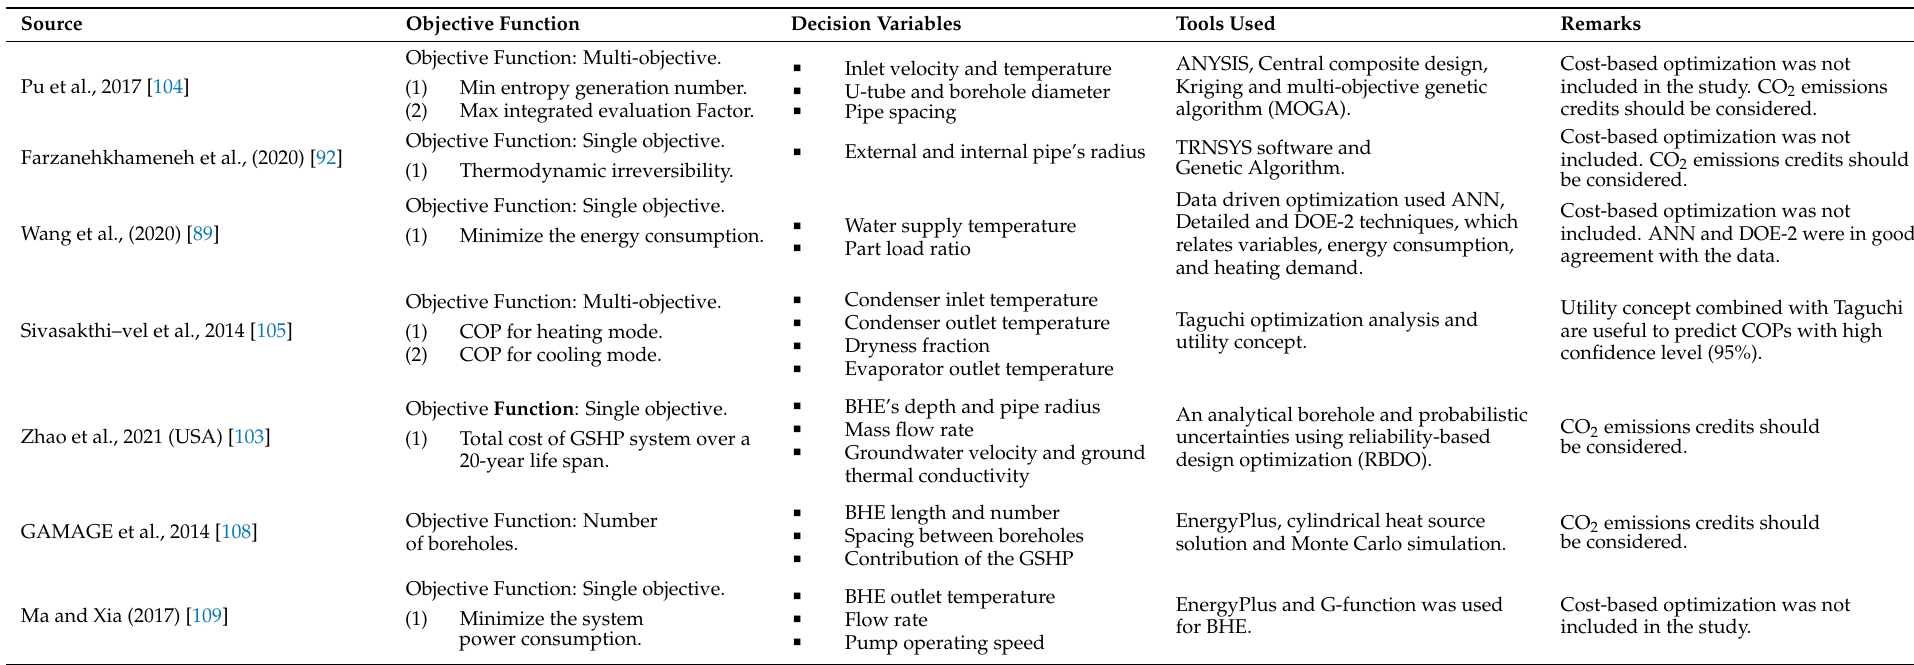
Table 4. Summary of the GSHP optimization (objective function, decision variables, and modelling approach. Source Objective Function Decision Variables Tools Used